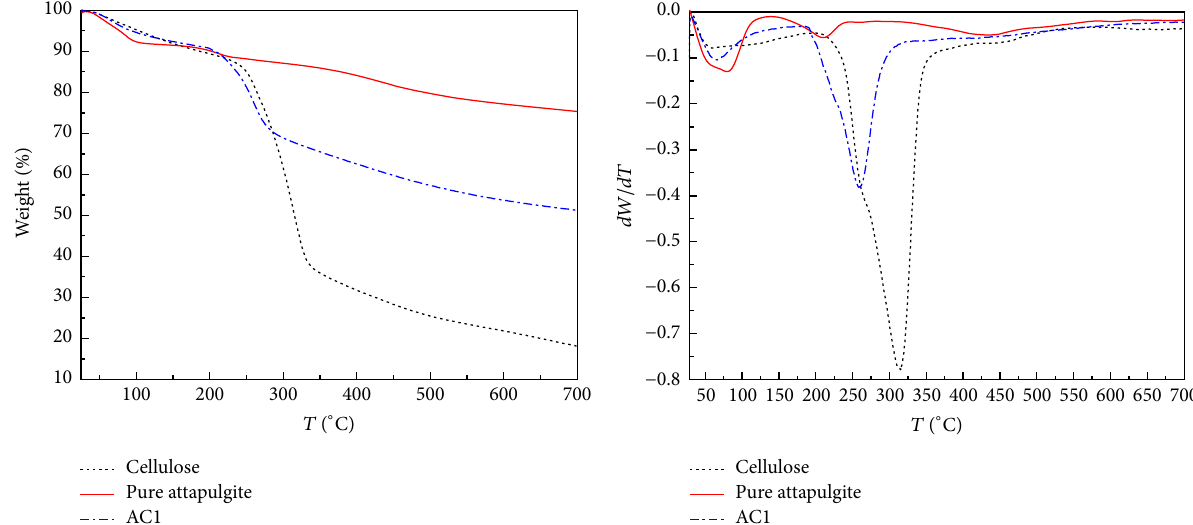
Figure 5: The TG and DTG of cellulose, attapulgite, and AC1.